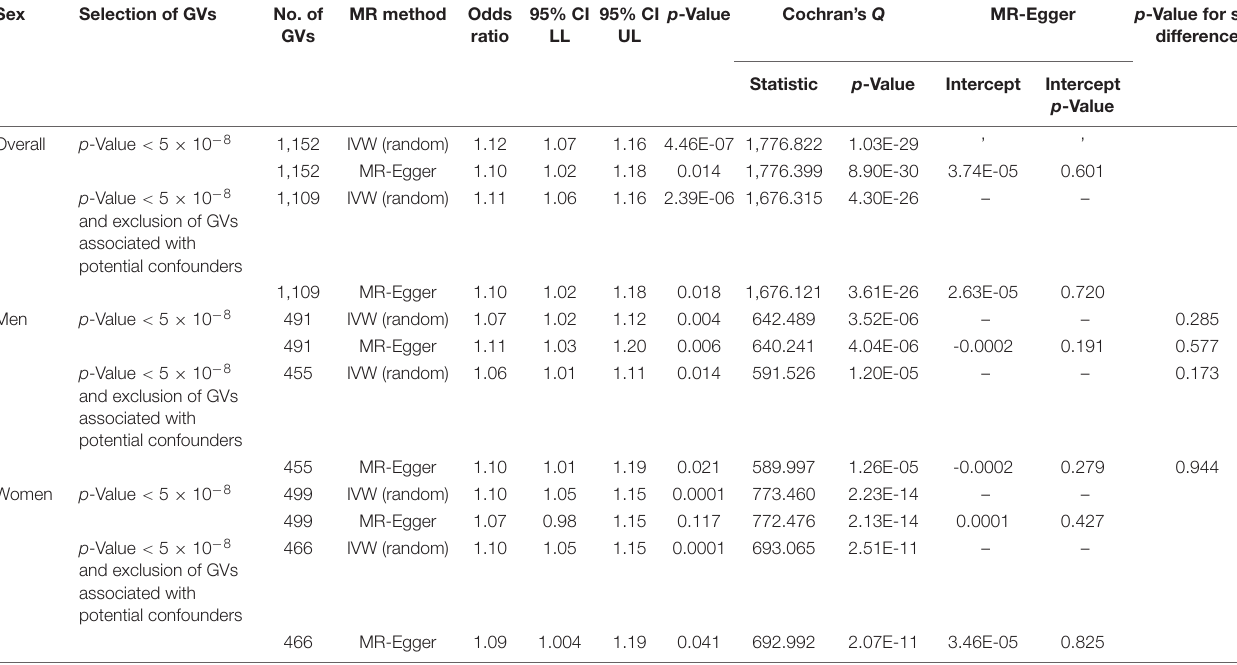
TABLE 4 | Multivariable Mendelian randomization association of basal metabolic rate with neoplasm adjusted for insulin-like growth factor 1. Sex Selection of